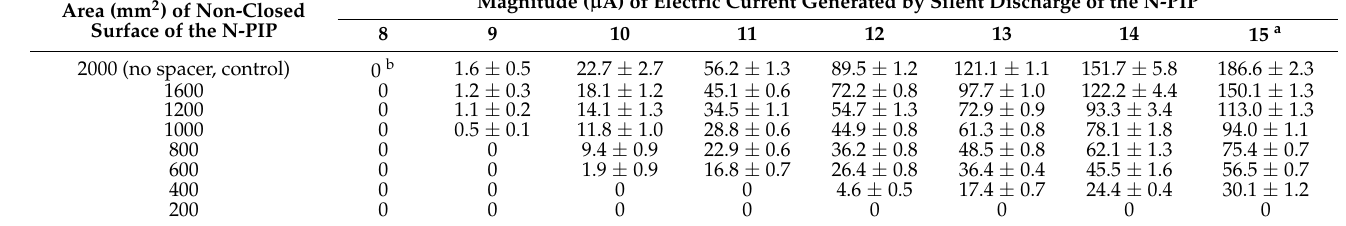
Table 1. Interception of current flow generated through silent discharge of a negatively charged polyvinyl chloride (PVC)-insulated iron plate (N-PIP) of an electric field producer (EFP), achieved by closing the surface of the N-PIP with acrylic plates at different degrees.